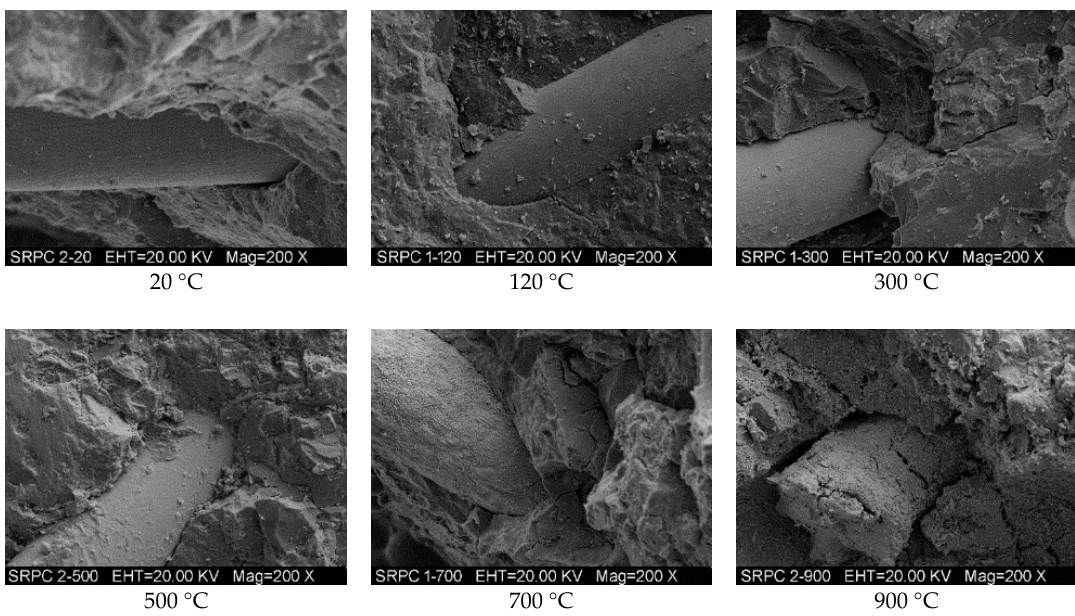
Figure 19. SEM micrographs of the bonding interface between steel fiber and RPC matrix at different temperatures.